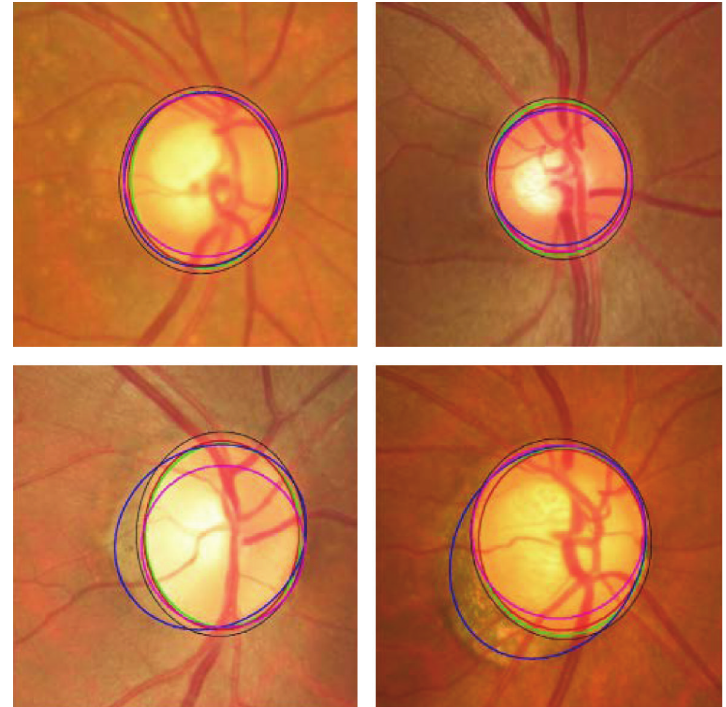
Figure 14: Optic disc segmentation using the proposed method (red), level set method (blue), FCM method (black), CHT method (cyan), and ground truth (green).